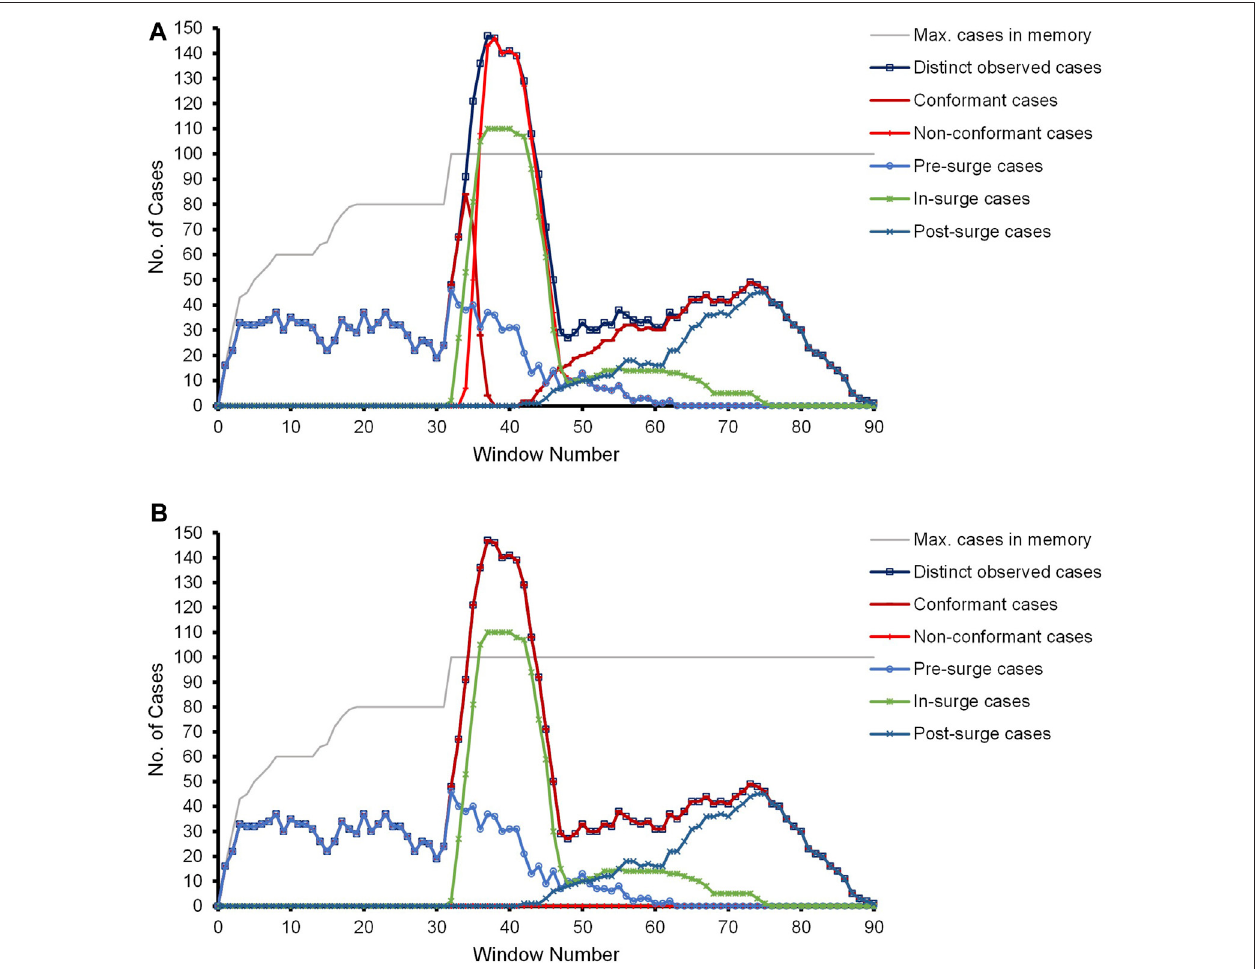
FIGURE6| ResultsoftheexperimentwiththeCCC ’ 19syntheticeventdata. (A) Pre fi x-alignmentswithoutourpre fi x-imputationmethod. (B) Pre fi x-alignmentswith our pre fi x-imputation